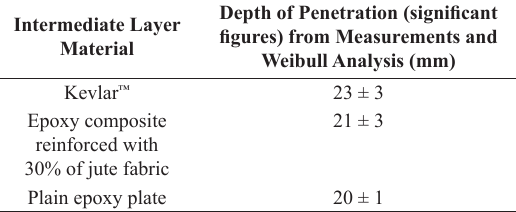
Table 1. Average depth of penetration in the clay witness backing different multilayered armors. Depth of Penetration (significant Intermediate Layer figures) from Measurements and Material